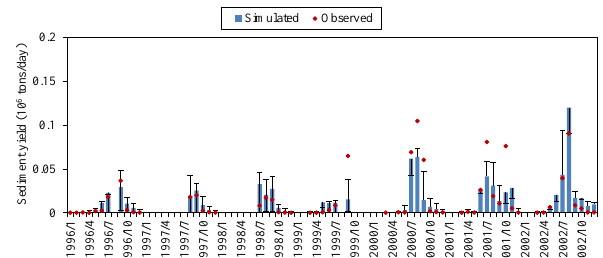
Fig. 10. Uncertainty analysis results of streamflow for the calibra- tion period; the 95PPU band is shown by thin black bars.